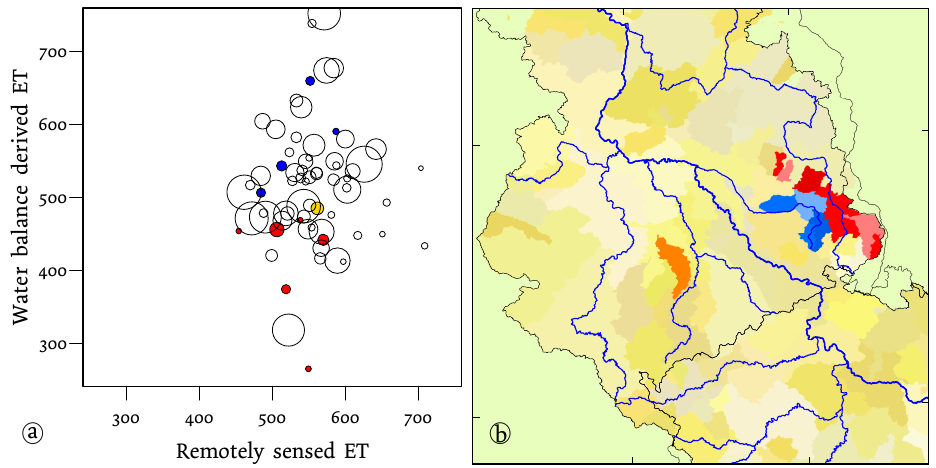
Fig. 16. Impacts of open cast mining on water balance derived ET. Red: sub-basins along the Spree River with maximum ground water pumping in the 1980s. Blue: Schwarze Elster River sub-basins with less pronounced peak before 1970. Yellow/orange: Pleiße River sub- basin covering an open cast mining area near